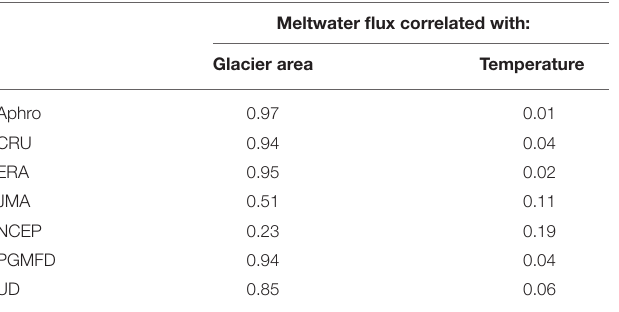
Meltwater flux correlated with: Glacier area